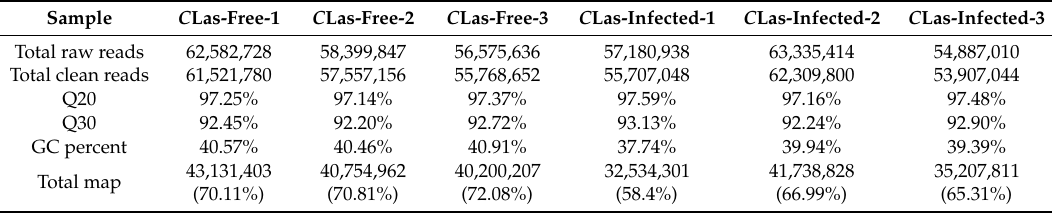
Figure 1. The structure of the D. citri midgut, and the PCR detection of Candidatus Liberibacter stereomicroscope. ( B ) Agarose gel electrophoresis analysis in C Las-free groups and C Las-infected groups. M, 2000 DNA marker; PC, positive control; NC, negative control. ff erent treatments in D. citri Table 1. A summary of the transcriptomes in the different treatments in D. citri . Table 1. A summary of the transcriptomes in the di